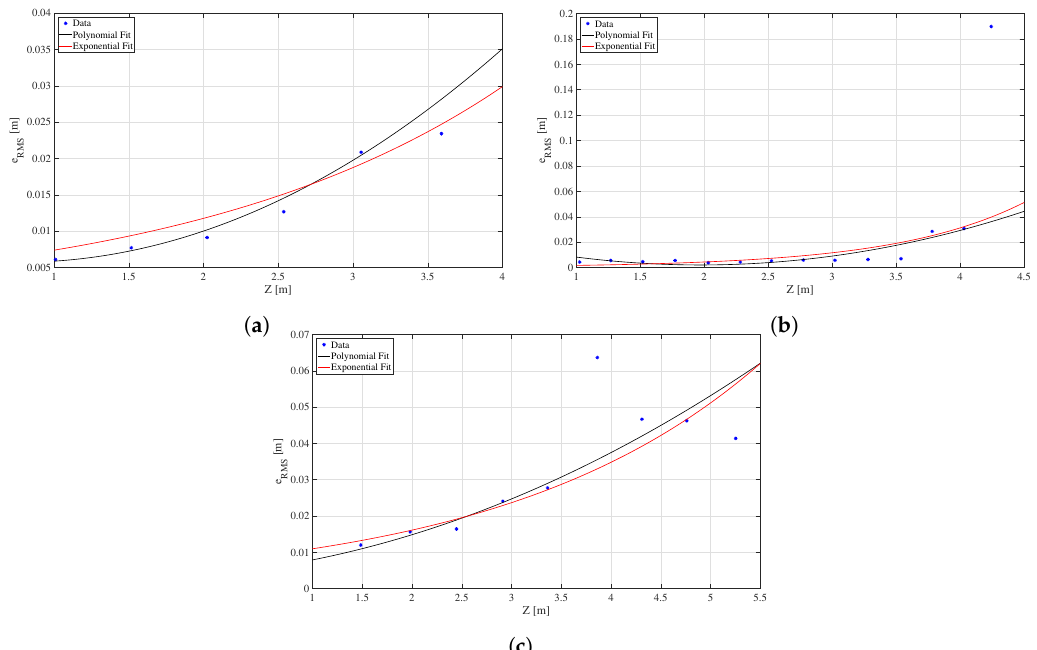
Figure 4. RMS error for ( a ) Kinect v1, ( b ) Kinect v2 and ( c ) ZED, represented for polynomial and exponential